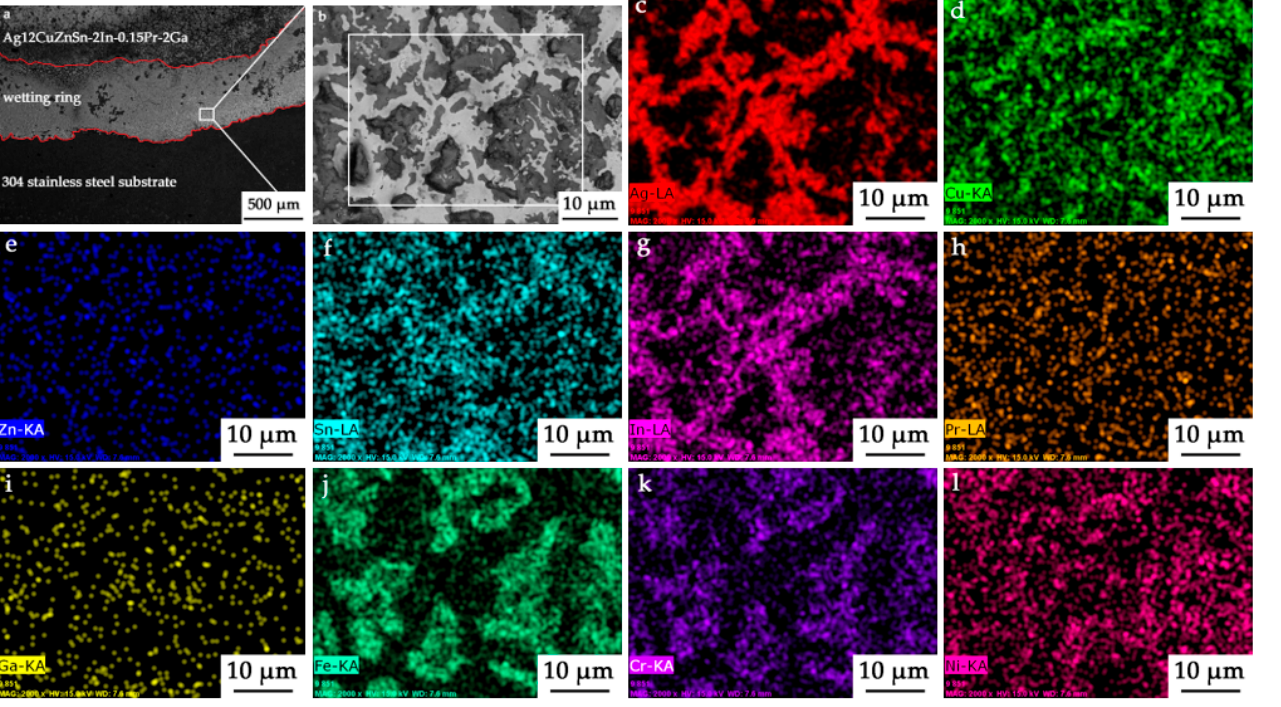
Figure 5. ( a ) SEM image of surface appearance after spreading of 12AgCuZnSn-2In-0.15Pr-2Ga filler metal on 304 stainless steel substrate, ( b ) high magnification SEM image of area marked with white squares in ( a) , ( c – l ) EDX element mappings of the distribution of Ag, Cu, Zn, Sn, In, Pr, Ga, Fe, Cr, and Ni, respectively.